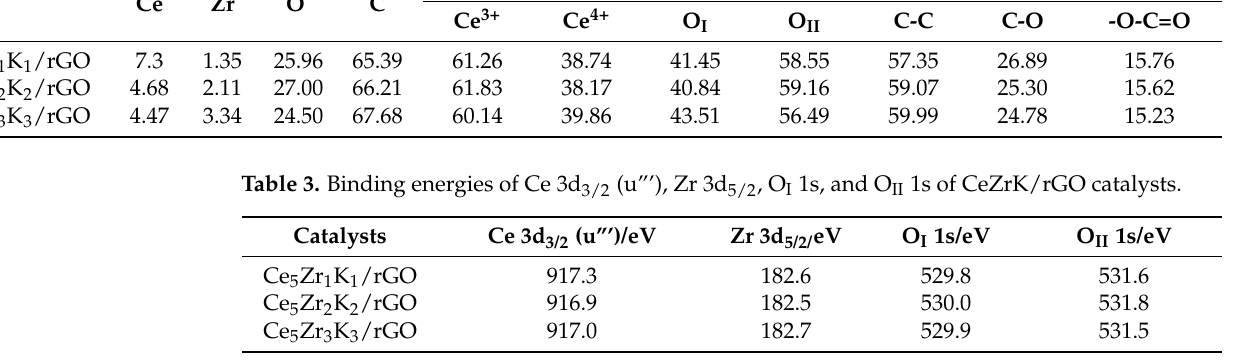
Table 4. Ce 3+ /Ce 4+ , O Ⅱ /O Ⅰ , and Ce/Zr ratios of CeZrK/rGO catalysts.